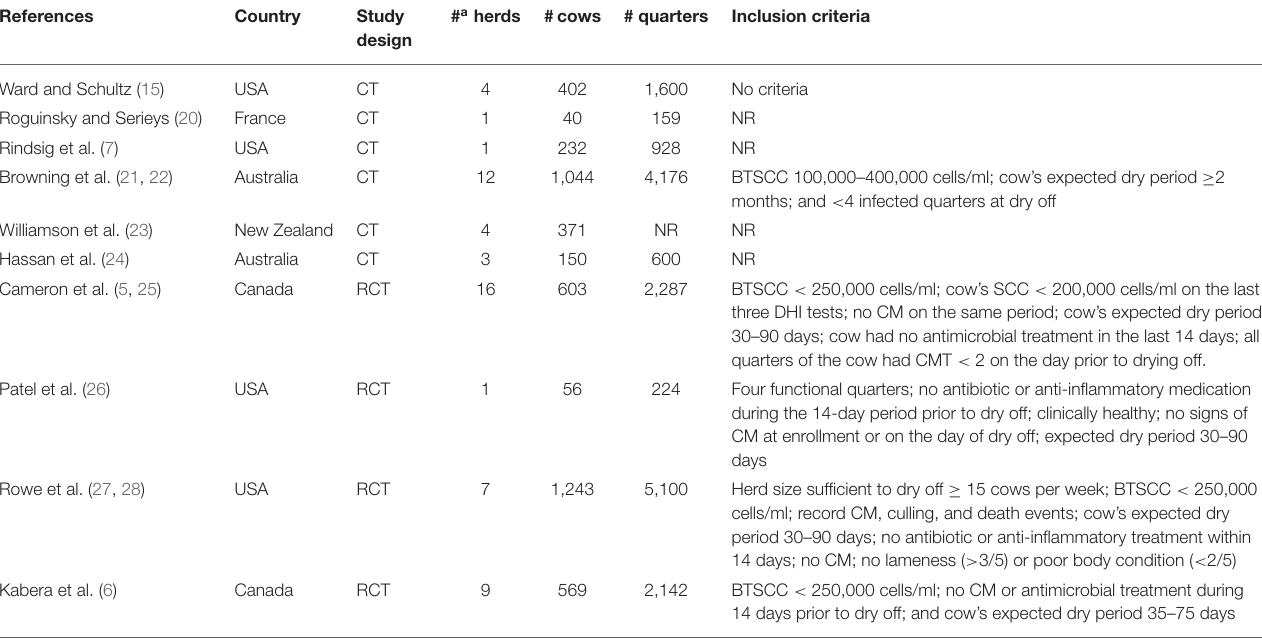
TABLE 1 | Characteristics of 13 articles representing 12 trials included in the systematic review comparing selective dry cow therapy and blanket dry cow therapy for curing and preventing intramammary